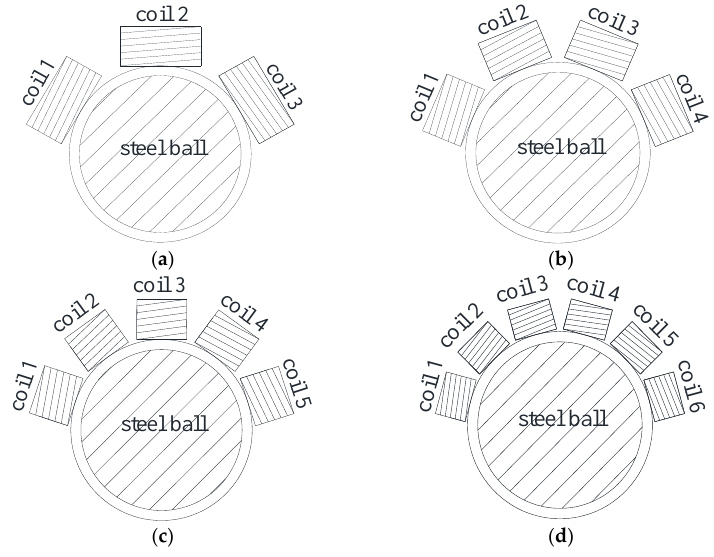
Figure 4. The arrangement of the multi-coil probe of the circumferential eddy current array (CECA) sensor. ( a ) 3-coil probe arrangement of CECA sensor; ( b ) 4-coil probe arrangement of CECA sensor; ( c ) 5-coil probe arrangement of CECA sensor; ( d ) 6-coil probe arrangement of CECA sensor.